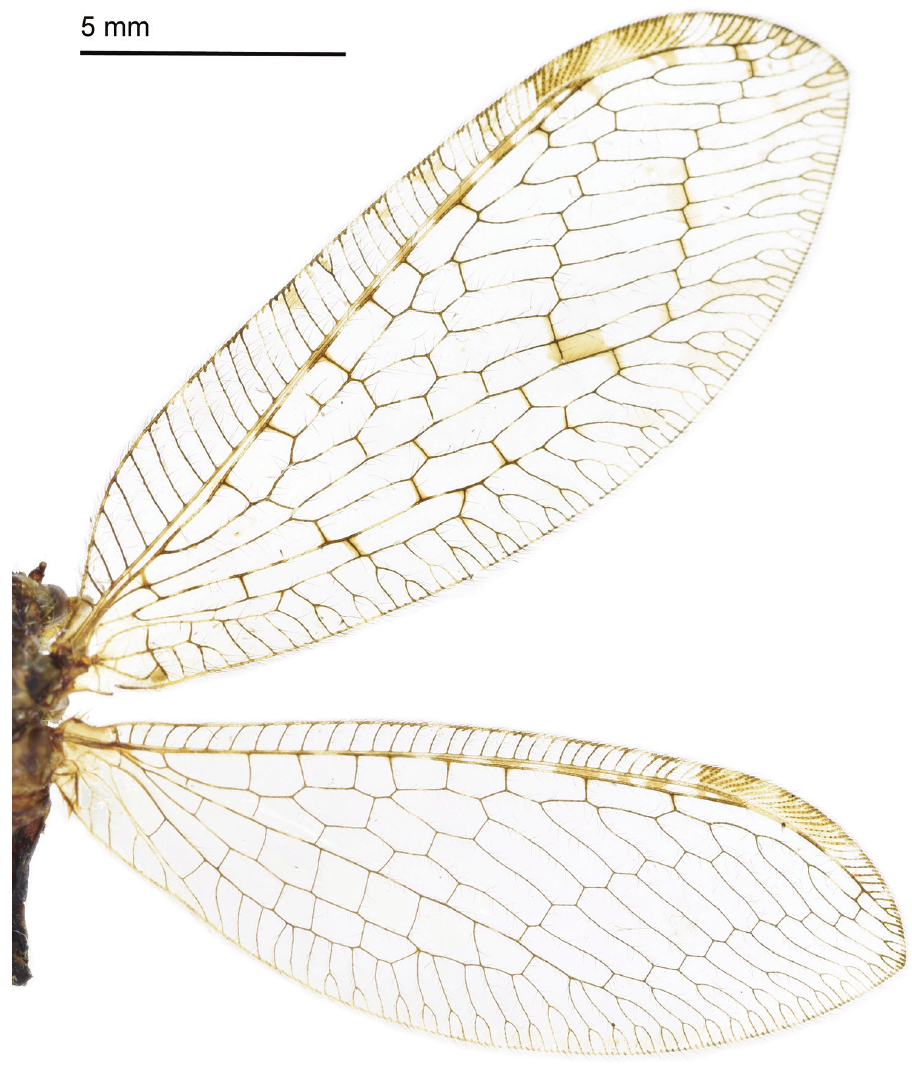
Figure 36. Wings of Heterosmylus shennonganus Yang, 1997.